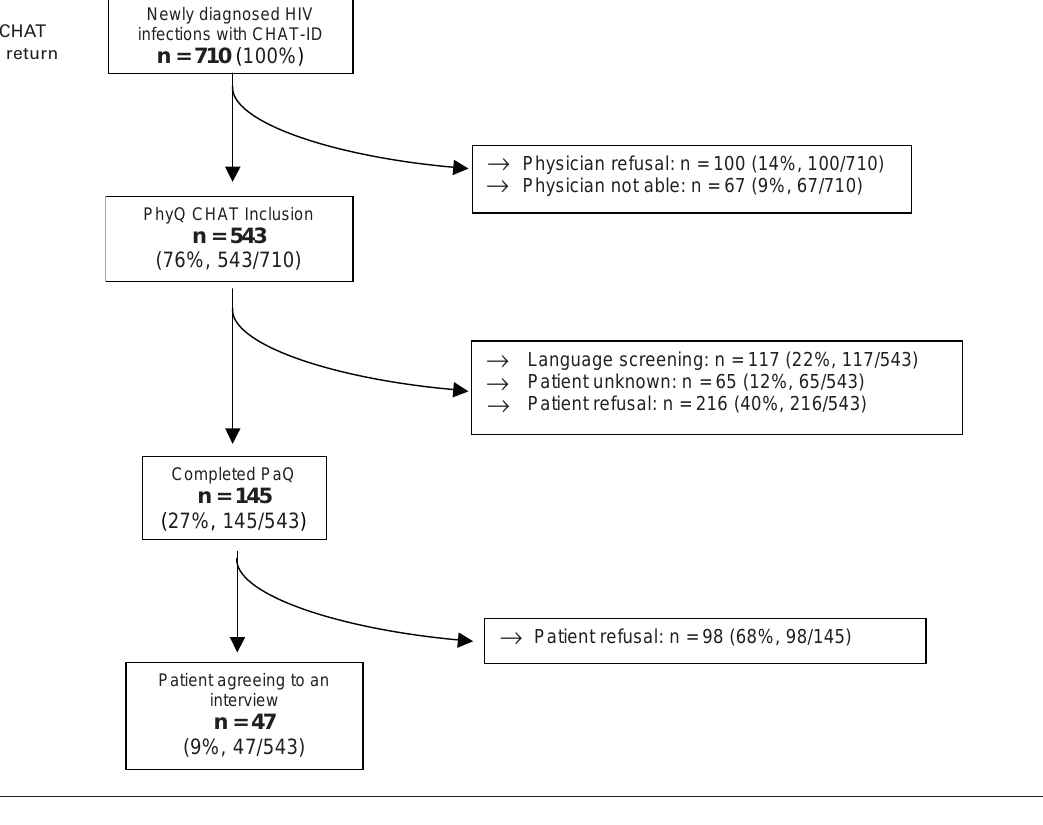
Demonstrated addi- tional effort needed for the return of PhyQ and